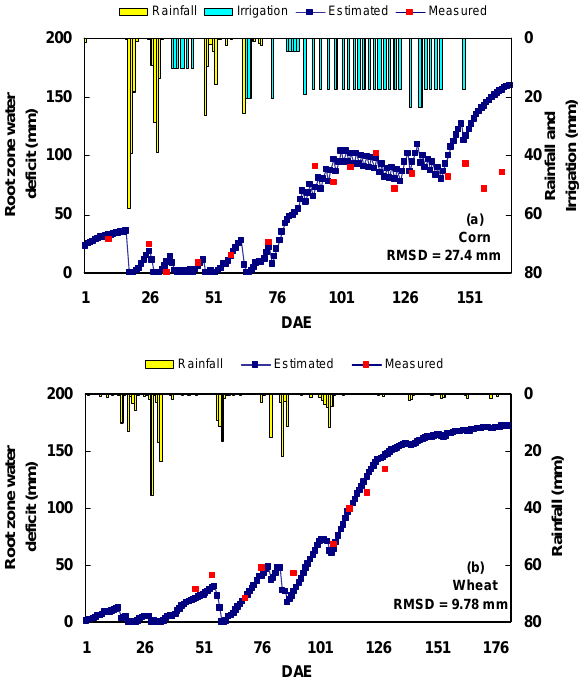
Fig. 4. Daily measured and estimated root zone water deficit for Fig.4 Daily measured and estimated root zone water deficit for corn (2008) (a) and wheat 23 corn (2008) (a) and wheat (2009) (b) using a radiometer-estimated (2009) (b) using a radiometer-estimated K cb. (DAE= day after emergence). 24 K cb . (DAE=day after emergence).